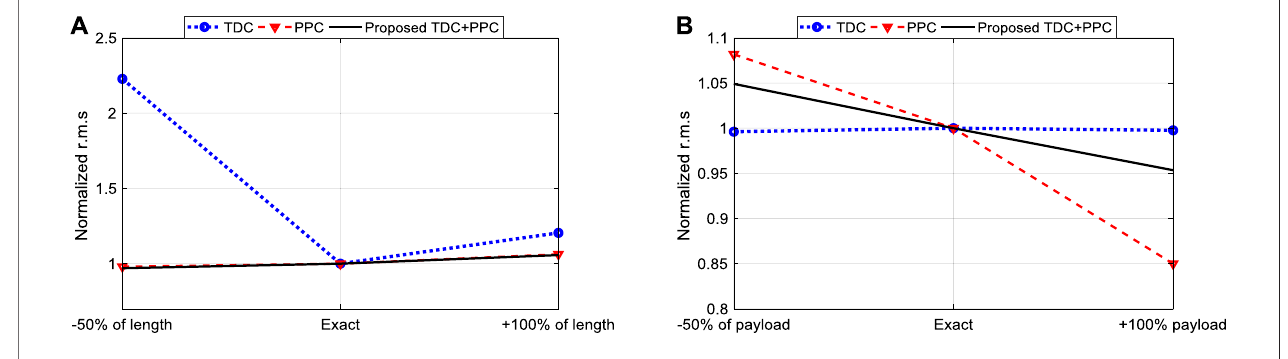
FIGURE 12 | Normalized r.m.s based robustness analysis of TDC, PPC, and iTDC+PPC: (A) Change of arm length; (B) Change of payload mass.